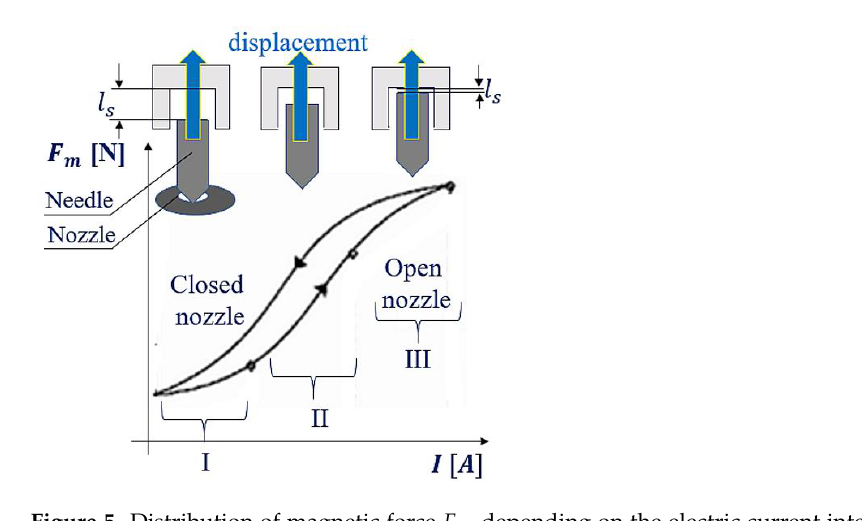
Figure 5. Distribution of magnetic force 𝐹 𝑚 , depending on the electric current intensity I and the needle retraction into the injector core (gap 𝑙 𝑆 ).